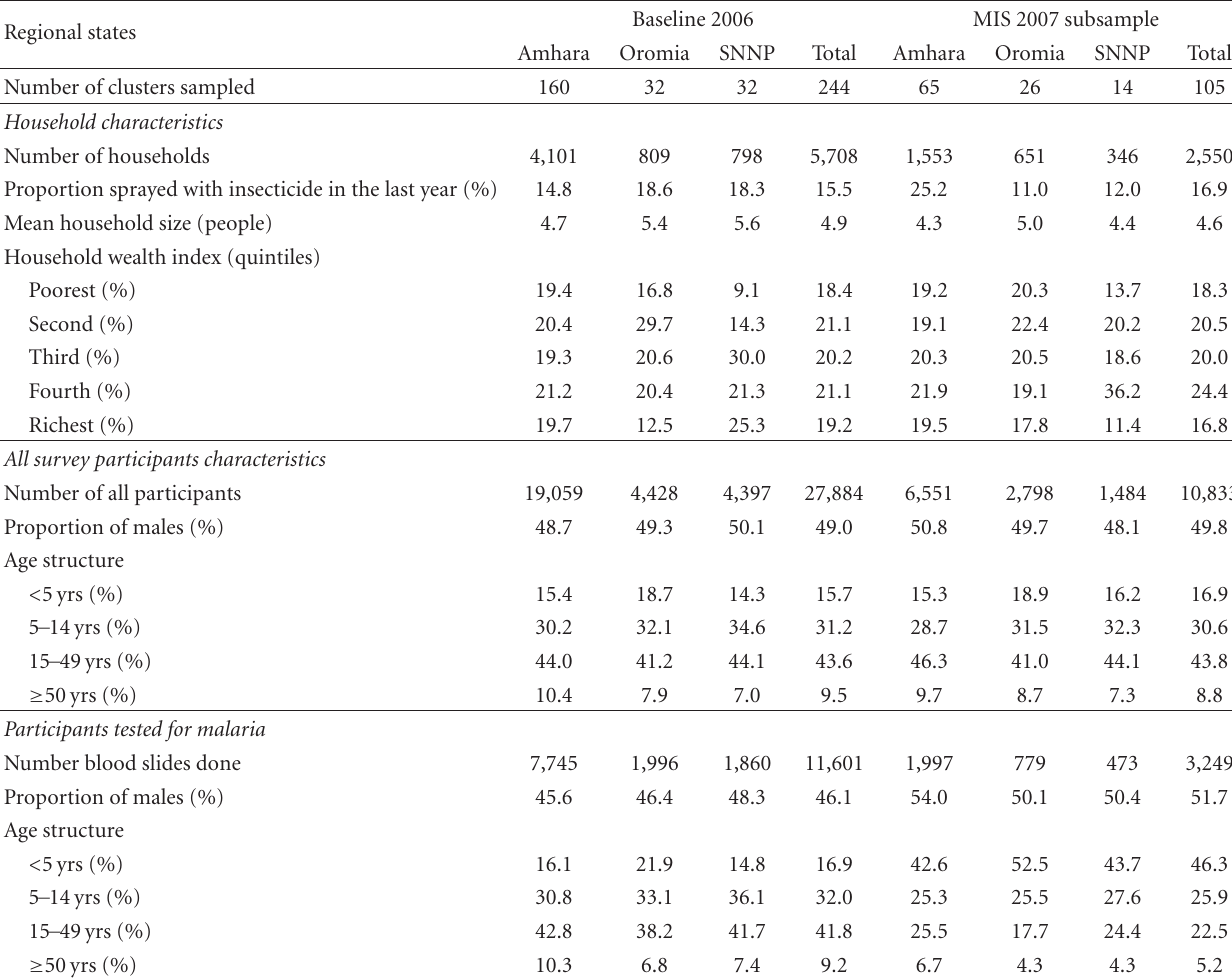
Table 1: Characteristics of study households and participants in malarious areas of three regional